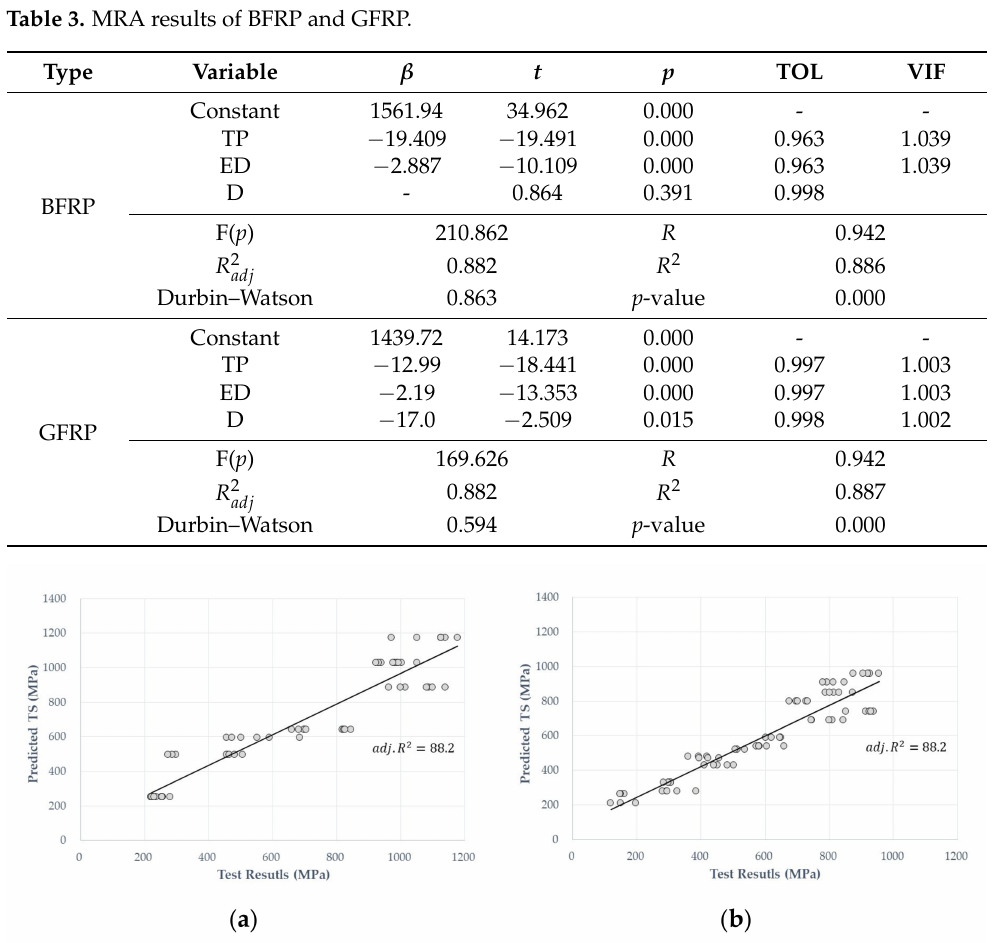
Figure 3. Relationship between the predictive and test values from the MRA results for the ( a ) BFRP and ( b ) GFRP predictive